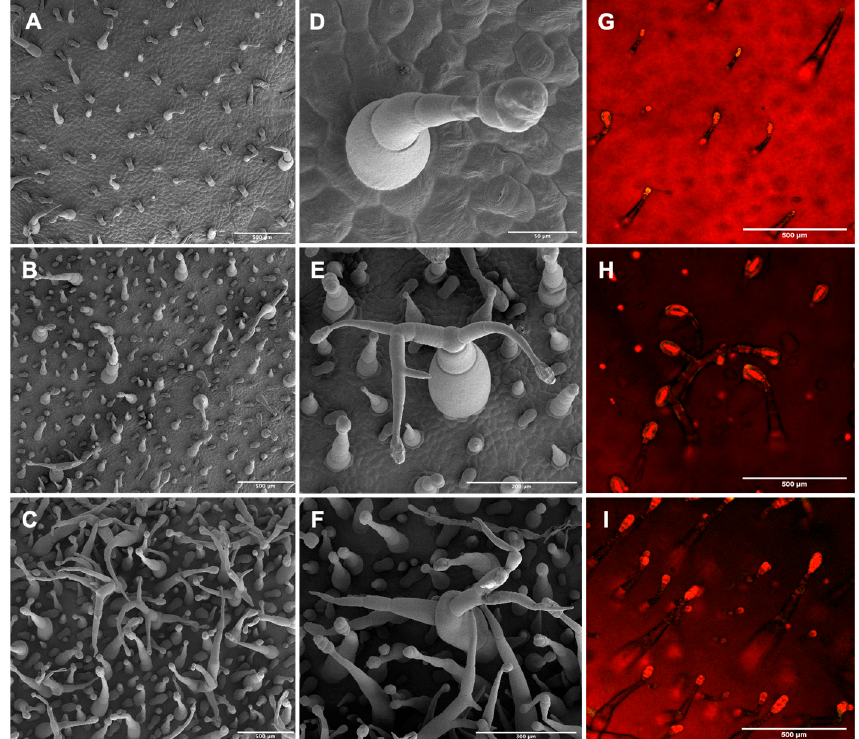
Figure 4. Scanning Electron Microscopy and Fluorescence Microscopy micrographs of wt and transgenic tobacco leaves. ( A – C ), SEM images of adaxial leaf surface of wt ( A ) and two transgenic lines L3 ( B ) and L1 ( C ). ( D – F ) Higher resolution micrographs of representative glandular trichomes from wt ( D ) and two transgenic lines L3 ( E ) and L1 ( F ). ( G – I ) Fluorescence Microscopy images of wt ( G ) and two transgenic lines L3 ( H ) and L1 ( I ) captured with a Nikon A1R confocal microscope. All samples were taken from tissue adjacent to the midrib of the third leaf from the apical meristem, and 2 cm from the petiole. In all cases, the images shown for each genotype are representative of other biological replicates. Fluorescence signals indicating glandular trichomes were counted from each tissue sample ( n = 3). Scale bars in ( A – C ): 500 µ m; in ( D – F ): 200 µ m; in ( G – H ): 500 µ